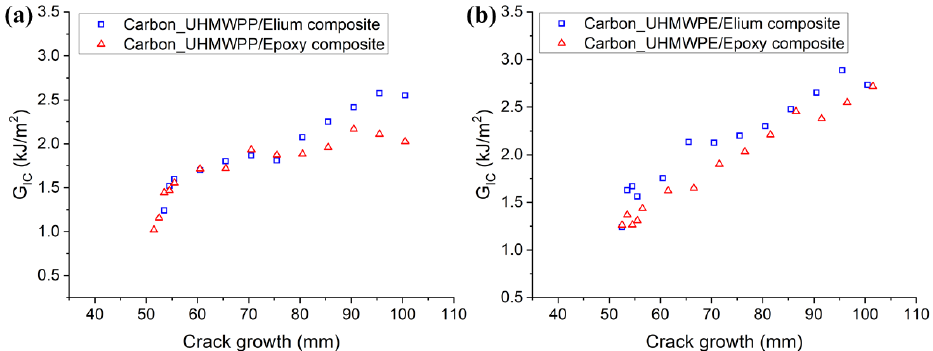
Figure 8. Resistance graphs for ( a ) Hybrid Carbon_UHMWPP ( b ) Hybrid Carbon_UHMWPE com- posite configurations.